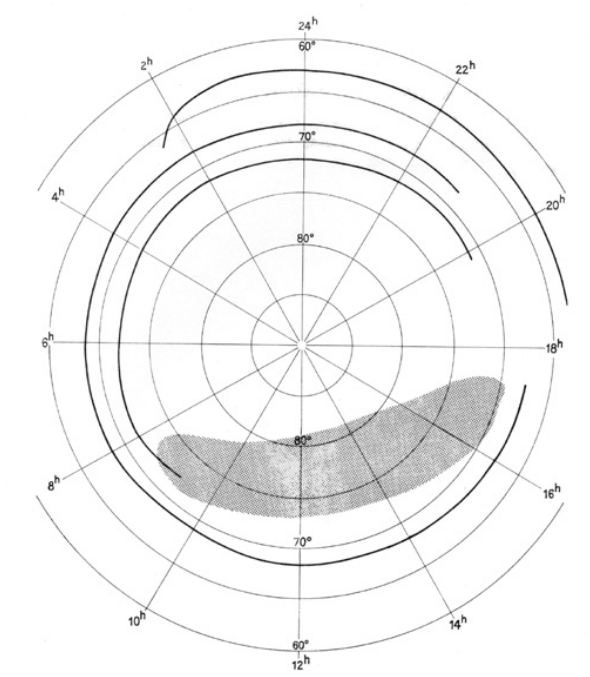
Figure 24. The four auroral regions (Lassen,